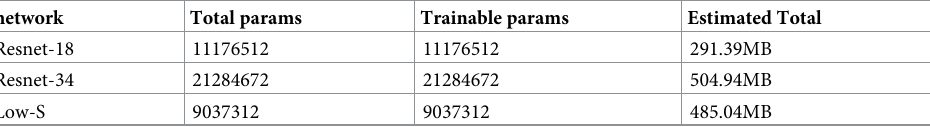
Table 1. Comparison of Resnet-34 network and Low-S network in the number of parameters and memory usage.